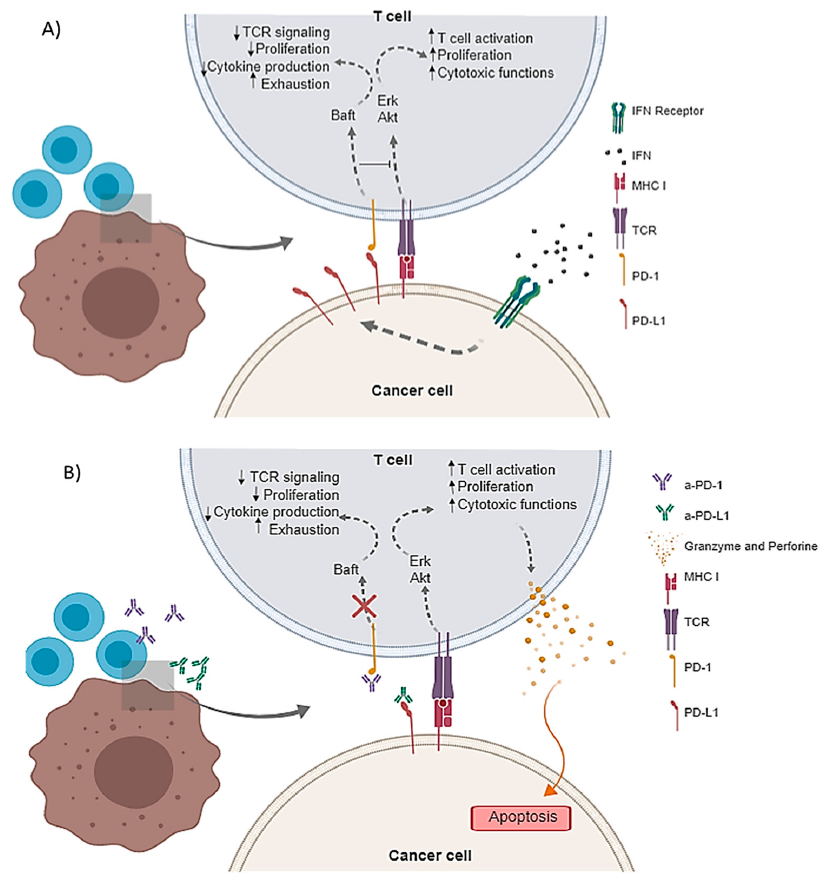
Figure 1. Schematic representation of PD-1/PD-L1 axis. ( A ) PD-L1 overexpression in response to Interferon Ɣ (IFN Ɣ ) leads to the T cell exhaustion and anergy; ( B ) with the use of a-PD-1 or a-PD-L1 antibodies, T cells are able to exert their cytotoxic effector activity and promote cancer cell apoptosis. Currently, there are several PD-1/PD-L1 inhibitors approved for clinical use: Pembrolizumab, Nivolumab, and Cemiplimab to block PD-1, and Atezolizumab, Durvalumab, and Avelumab for PD-L1 [9,11].